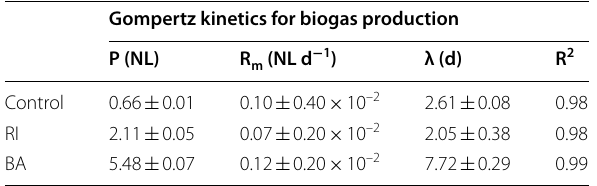
Table 2 Gompertz kinetics data for methane production in different experimental